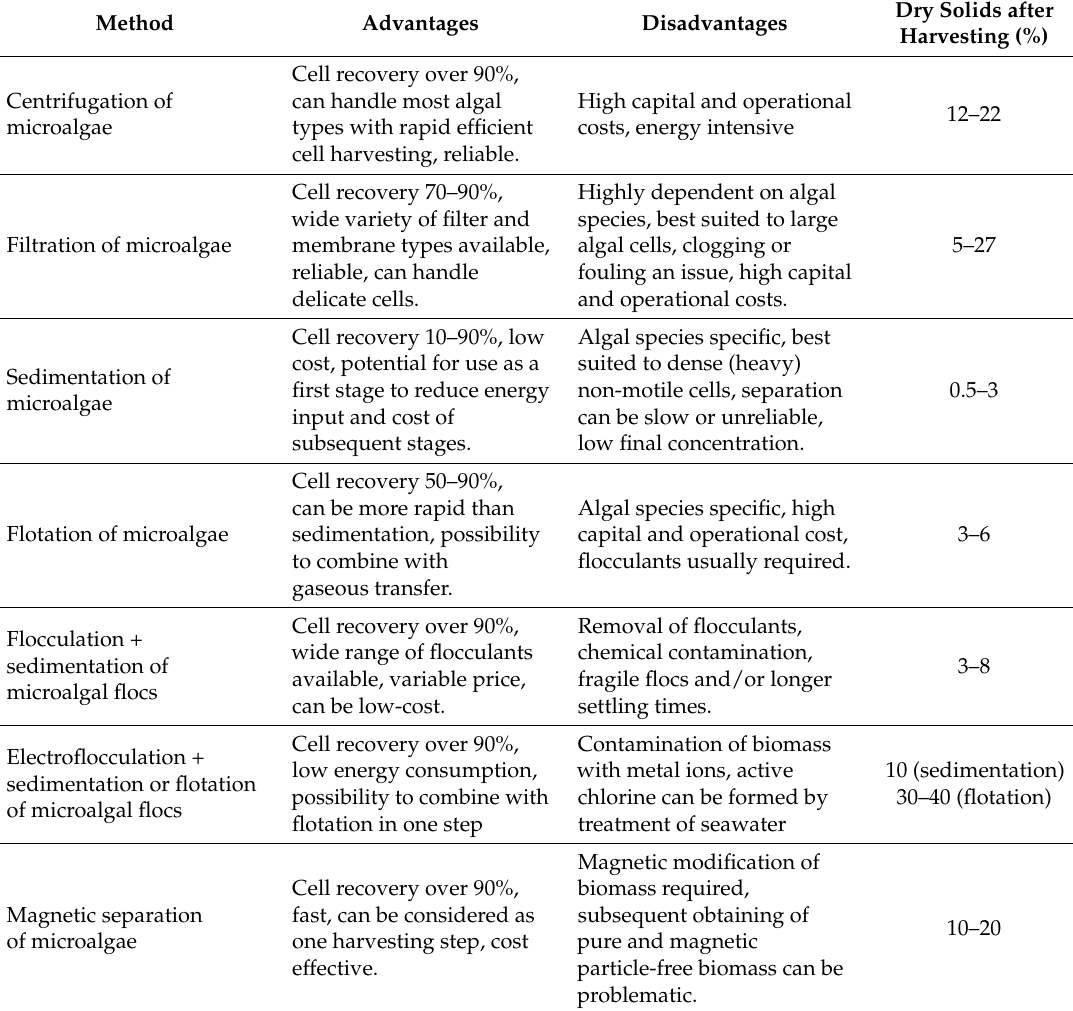
Table 1. Comparison of microalgal harvesting methods